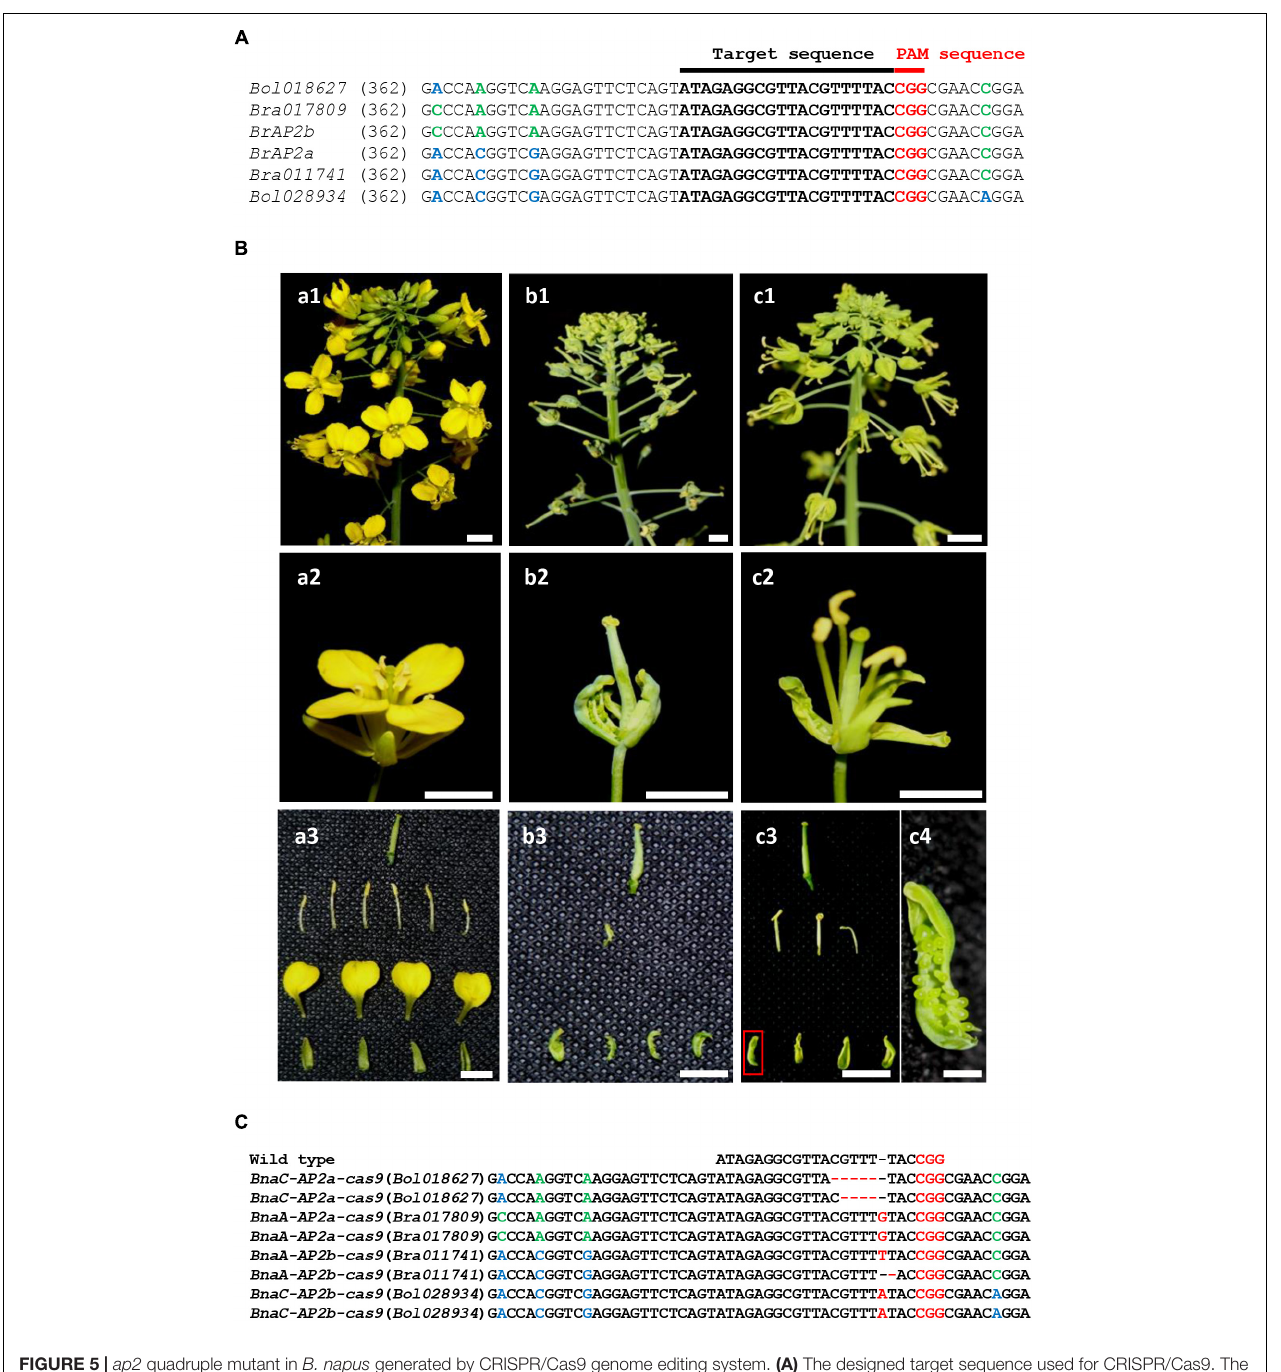
FIGURE 5 | ap2 quadruple mutant in B. napus generated by CRISPR/Cas9 genome editing system. (A) The designed target sequence used for CRISPR/Cas9. The PAM sequence is indicated in red. (B) a1–a3: wild-type Brassica (WT); b1–b3: a strong ap2 quadruple mutant; c1–c4: a weak ap2 quadruple mutant. a1, b1, c1: inflorescence; a2, b2, c2: flower; a3, b3, c3: floral organs; c4: enlargement of the floral organ shown in the red box in c3. The ap2 quadruple mutant of B. napus , which has a similar sepal-to-carpel and petal-to-stamen phenotype as the scm mutant of Brassica . (C) Sequencing results of the target sites in the strong ap2 mutant. Bars are 1 mm in c4 and 10 mm in all the others